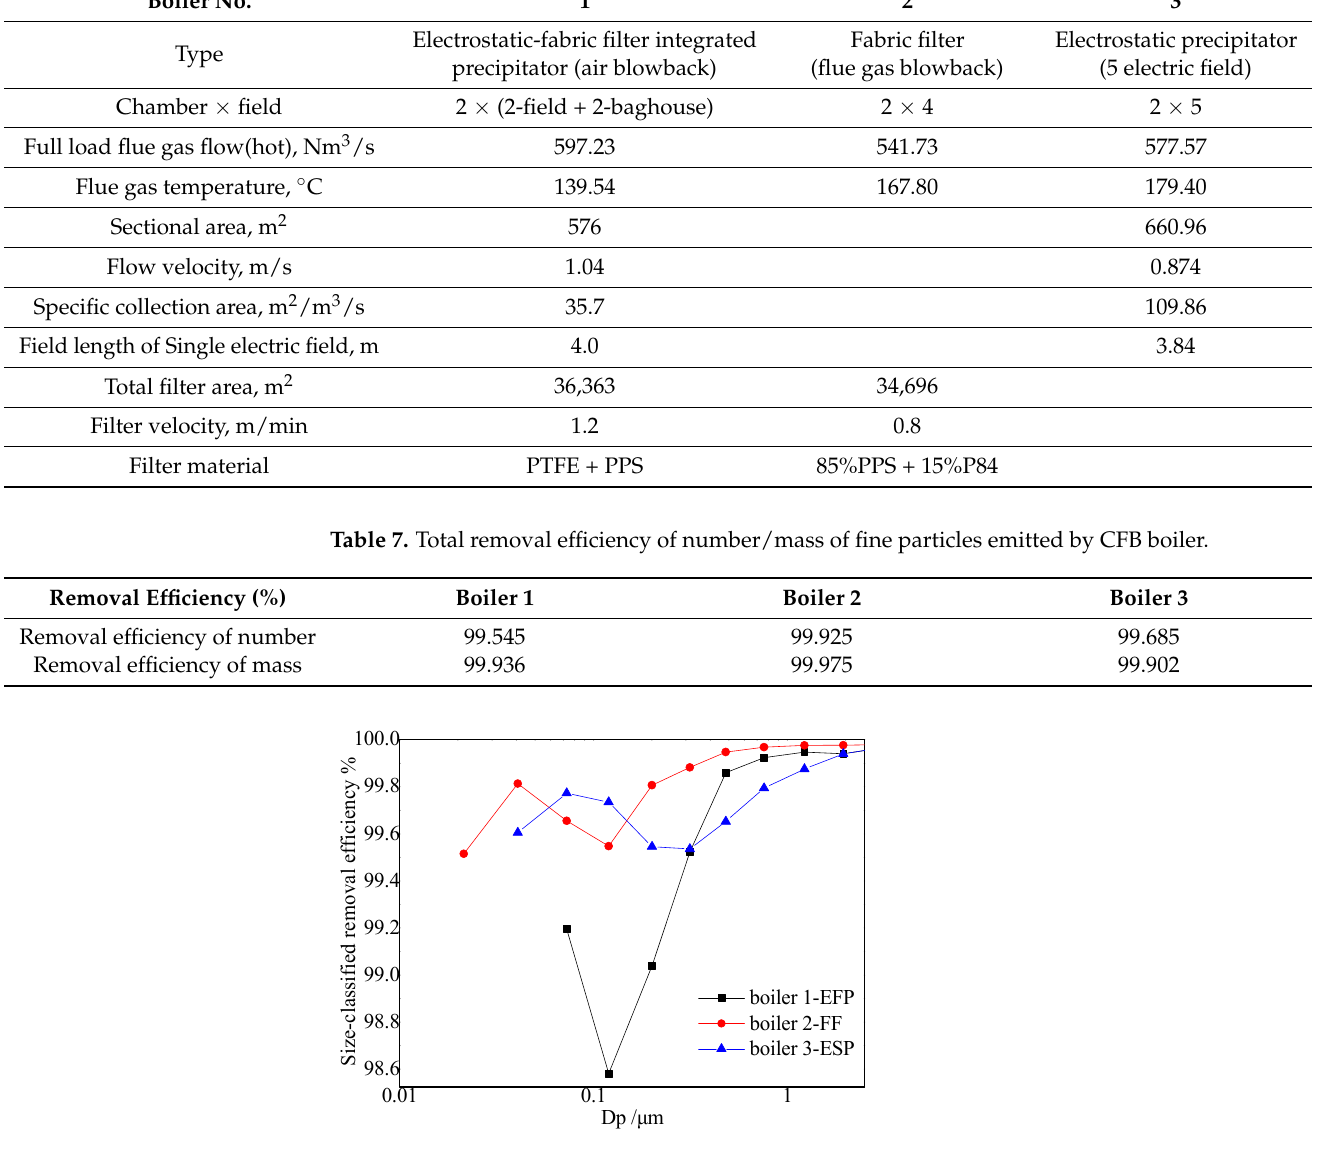
Table 6. Key parameters of the dust collectors of three boilers.